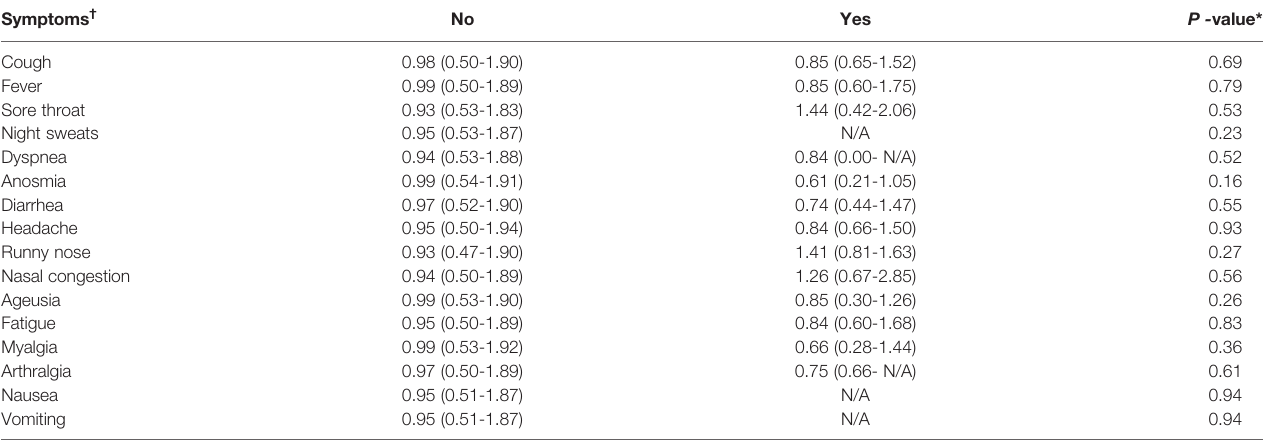
TABLE 9 | Fold of increase of NK TNF- a + cells after M. bovis CFP stimulation according to the different symptoms. Symptoms †